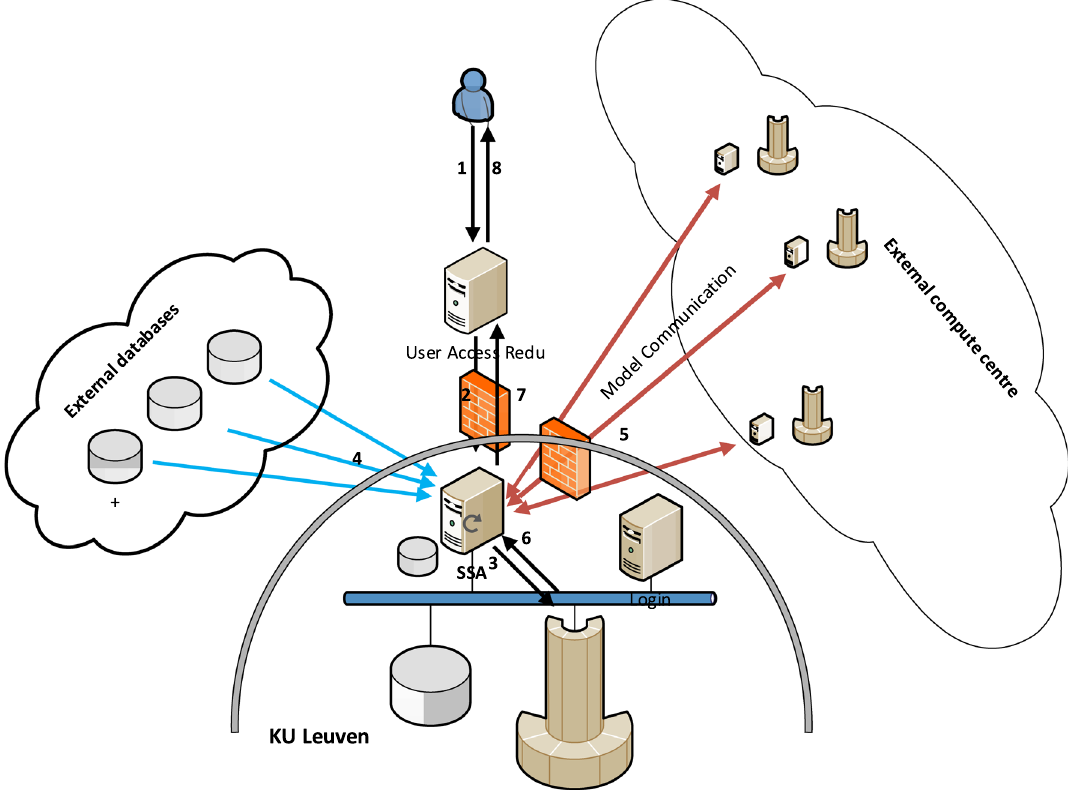
Fig. 1. Basic set-up of the federated VSWMC-P2 service with geographically distributed system